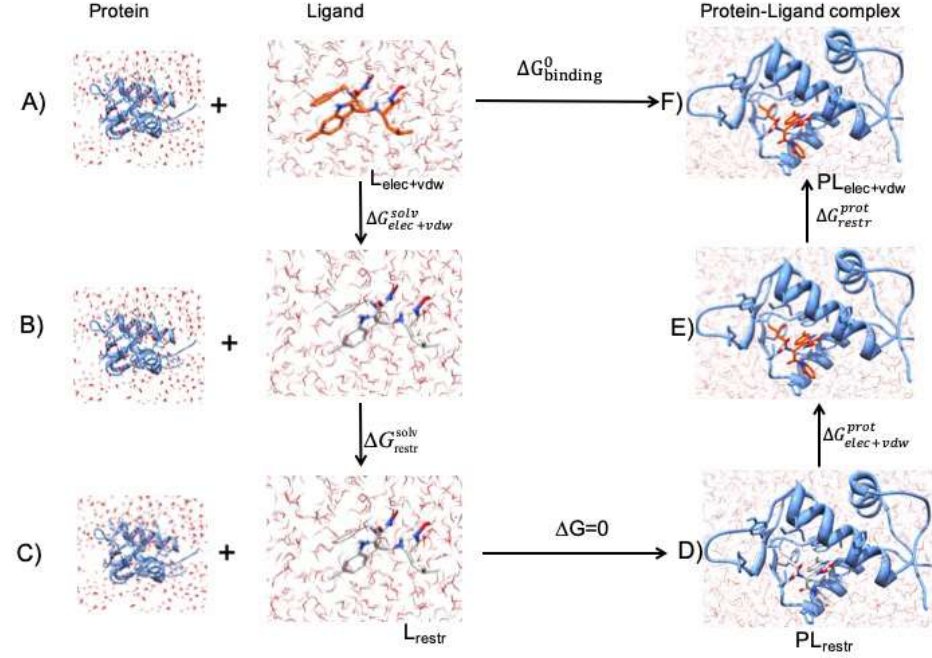
Figure 6. Scheme for non-physical thermodynamic cycle used to calculate absolute binding free energies, adapted from [12]. ( A ) The ligand (orange red) interacting fully with solution. ( B ) Electrostatic and van der Waals interactions turned o ff for ligand (light grey). ( C ) The non-interacting ligand is restrained (L restr ), ∆ G solv is calculated using the Boresch equation [11]. ( D ) Electrostatic and van der Waals interactions turned on for restrained ligand in complex with protein MDM2. ( E ) The ligand-protein complex with full interactions but restrained ligand. ( F ) Restraints removed resulting in fully interacting ligand in complex with protein MDM2. Protein and ligand were taken from PDB accession code: 4MDQ for representation of this cycle while the arrows represent the direction of cycle.